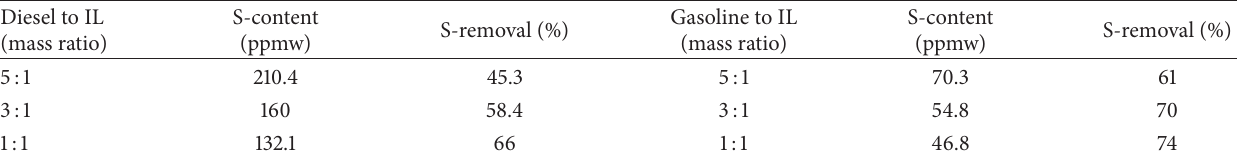
Table 3: Desulfurization of real fuels with [BMIM]Cl.